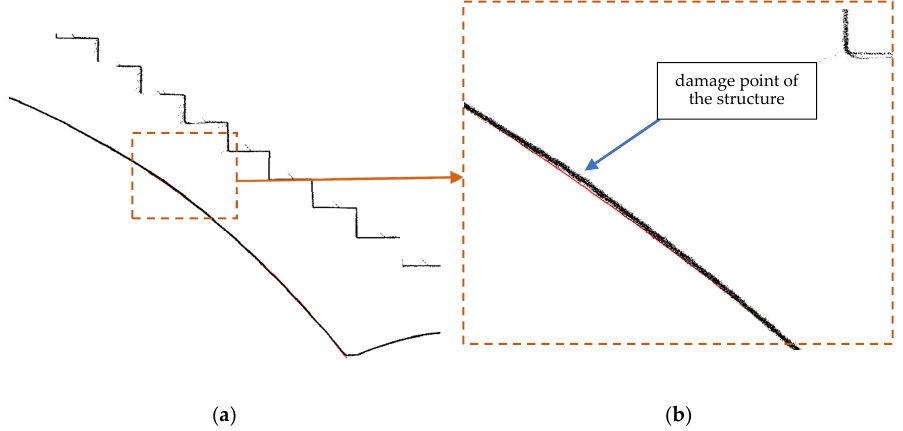
Figure 8. TLS data output for the point damage of the stair flight: section view of the stair flight ( a ) and point of damage ( b ).